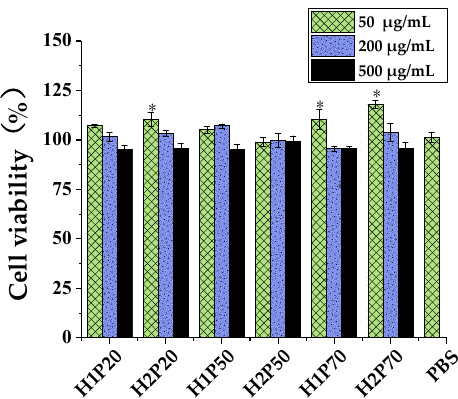
Figure 4. Viability of macrophage cells. Each value represents the mean ± SD. * p < 0.05 compared to the negative control (phosphate buffered saline (PBS) treatment).